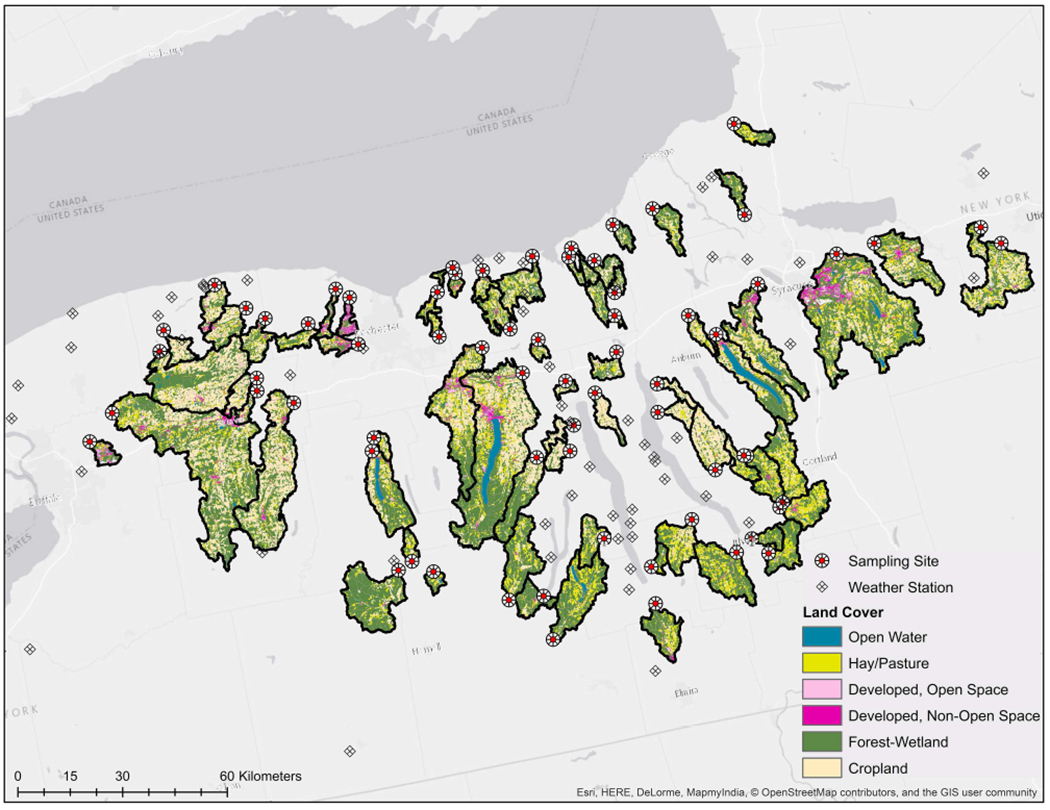
Map showing the study region, including land cover in the sampled watersheds as well as the location of the sampling sites and the NEWA weather stations.